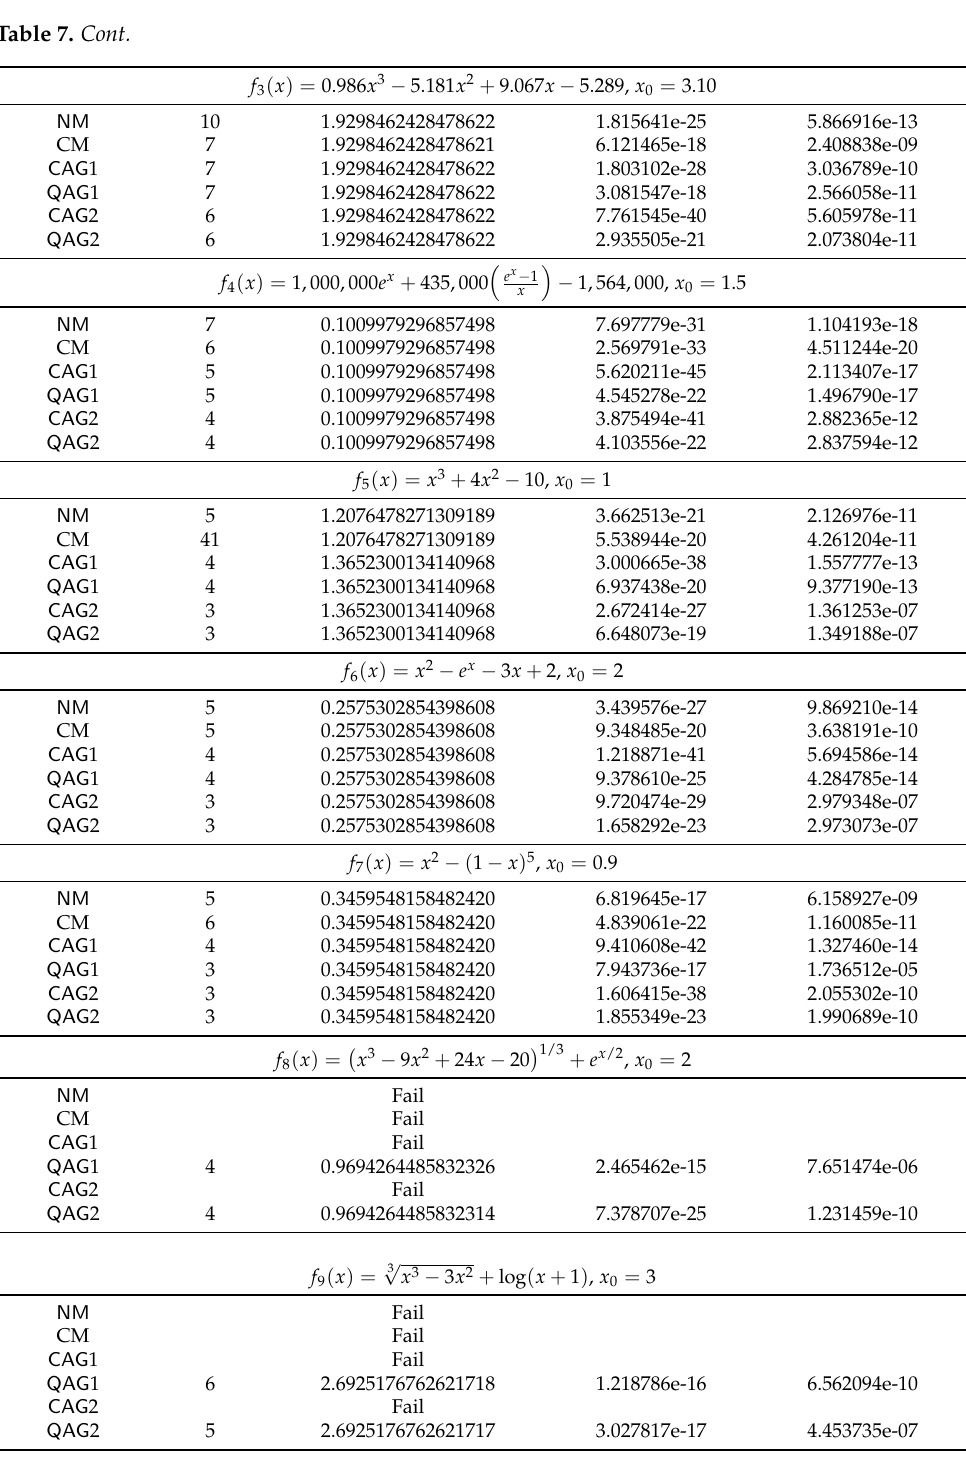
Table 7 compares the solutions obtained by using the classical and our the q -iterative methods. The results show that our q -analogue iterative methods QAG 1 and QAG 2 give the same results as the classical methods CAG 1 and CAG 2. The functions f 8 ( x ) , f 9 ( x ) are not differentiable at x = 2 and x = 3, respectively, when we choose x = 2 and x = 3 as initial guesses for f 8 ( x ) and f 9 ( x ) , respectively. Then, the iterative methods: NM , CM , CAG 1 and CAG 2 fail, while the new iterative methods QAG 1 and QAG 2 are applicable and give rapid convergent